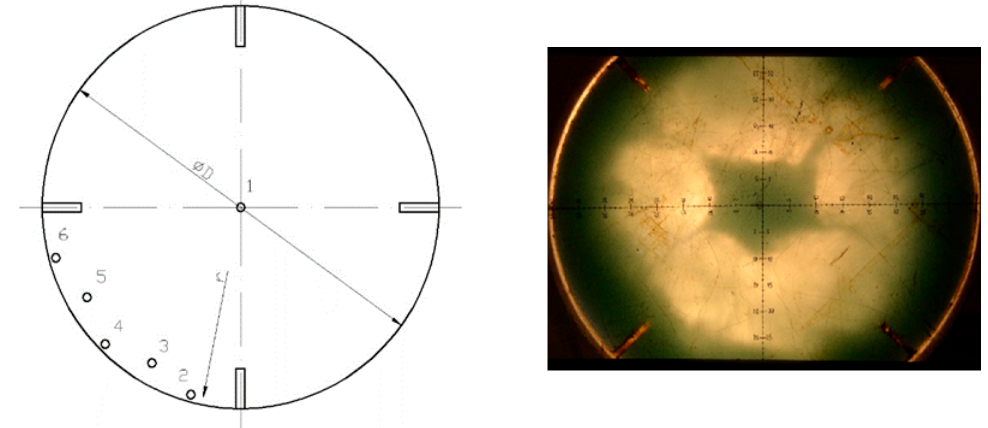
Figure 5. Location of electrodiffusion probes mounted at the vessel bottom (probe 1 – 2r/D = 0; probe 3, 5 – 2r/D = 0.89; probe 2, 4, 6 – 2r/D = 0.96).